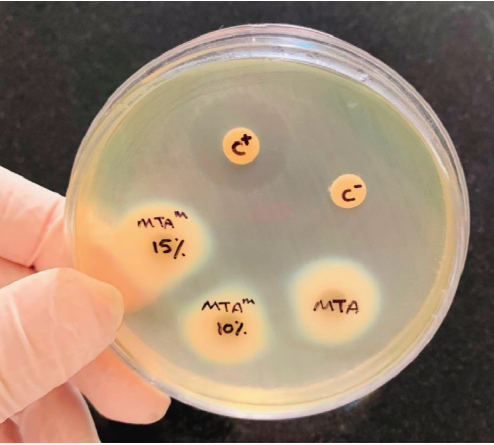
Figure 2: Growth inhibition zones in the samples after 24 hours (positive control, 0.2% CHX; negative control, Table 1: The means and standard deviations of colony counts (CFU/mL) based on the DCA test in the study groups. Microbial test